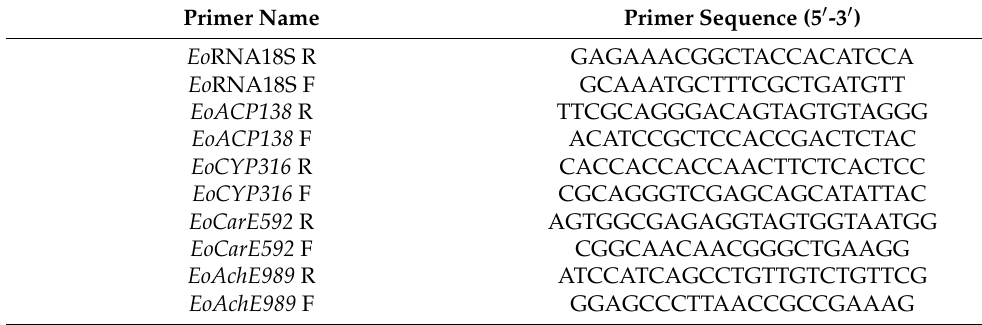
Table 1. Sequences of the primers for quantitative real-time